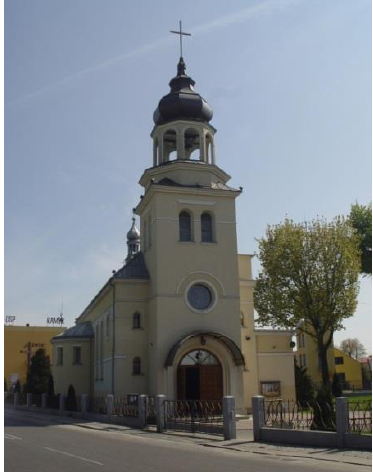
Figure 2. Church of Our Lady of Succour to the Faithful in Kamyk (built in 1951–52).